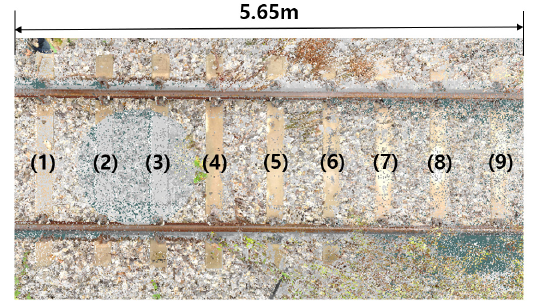
Figure 7. Testbed scan data.